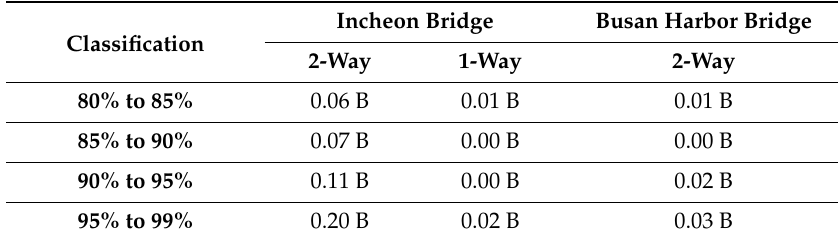
Table 16. Maritime accidents in Korea associated with bridges for 2010 – 2019.